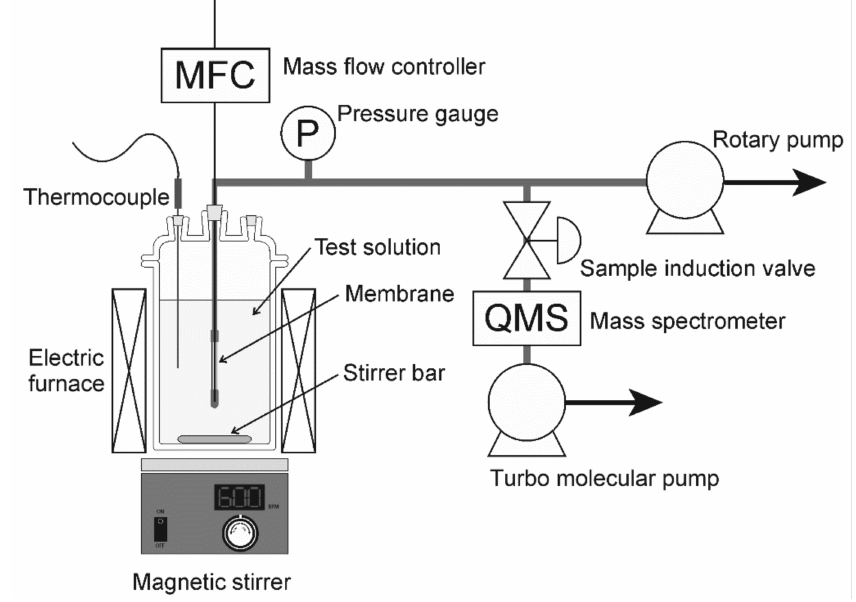
Figure 1. Schematic illustration of pervaporation unit used in this study